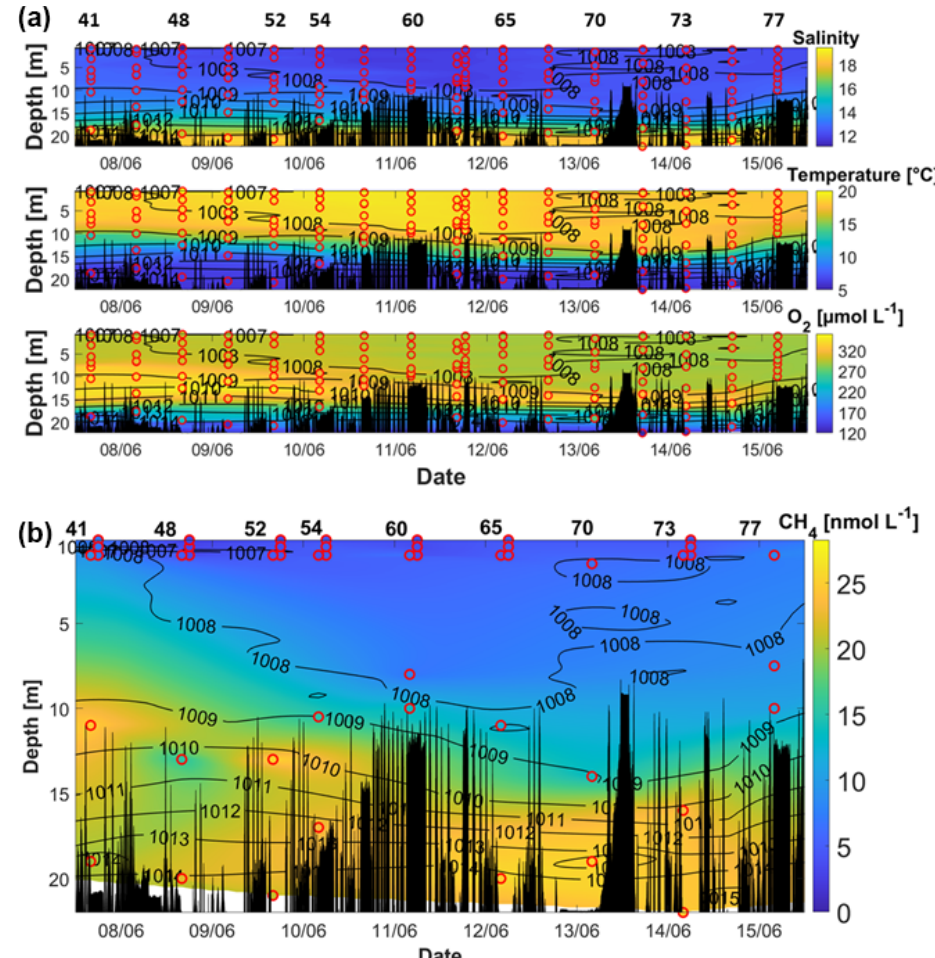
Figure 4. (a) Salinity (upper sub-panel), temperature (middle sub-panel), and O 2 (lower sub-panel) during AL510 in June 2018. (b) CH 4 concentrations during AL510. Red circles mark the location of the discrete measurements. Black peaks show the topography along the cruise track. Contour lines represent the density. Data for CH 4 were not available for the beginning of the cruise because the measurements started on 7 June 2018. The station numbers in (b) refer to those in Fig.